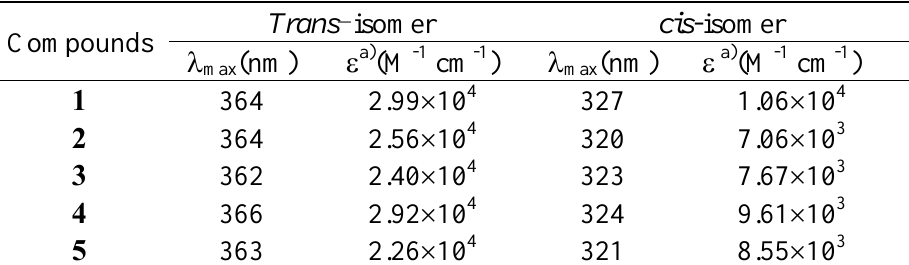
Table 1. Results of UV absorption of 1 , 2 , 3 , 4 and 5